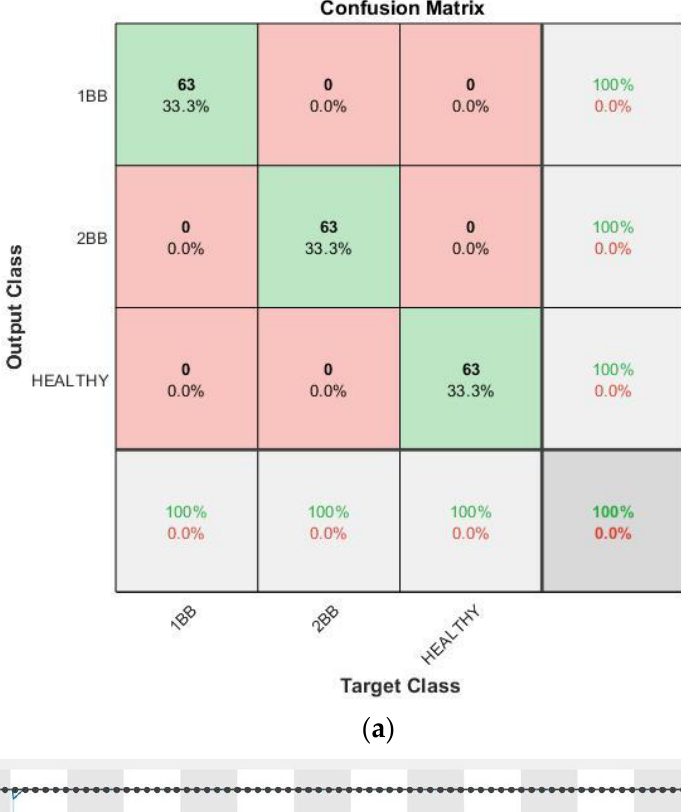
19 of 29 ( b ) Figure 15. Results for Schneider soft starter: ( a ) Confusion matrix. ( b ) Training progress. For the case of the ABB model, 567 training samples (189 samples per category) were used to train the CNN and 189 different samples (63 samples per category) were used for the validation. In Figure 16. it can be observed that the accuracy of the CNN also in this